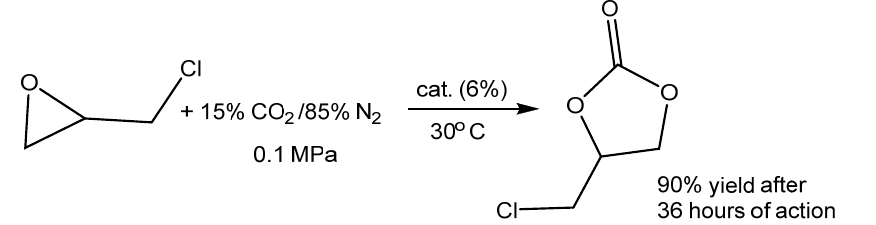
Figure 13. Structure of most effective OH-functionalized DBU-based IL [95].